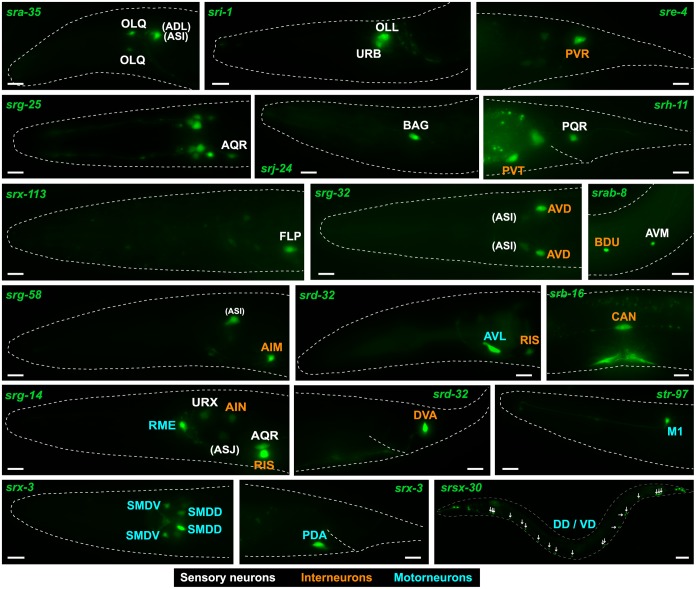
csGPCR reporters expressed in non-amphid/non-phasmid sensory neurons, interneurons, and motorneurons.Examples of GPCR reporters expressed in sensory neurons that are not amphids or phasmids (white font), interneurons (orange font), or motorneurons (blue font). Most examples represented here are from neuron classes that were not previously shown to express any sensory GPCR. Amphid neurons are shown in parentheses. Young adult hermaphrodites are shown. All scale bars, 10 μm, except srsx-30, which is 30 μm. See Table 3 for a complete summary of GPCR reporters expressed in inter- and motorneurons. GPCR, G-protein-coupled receptor.